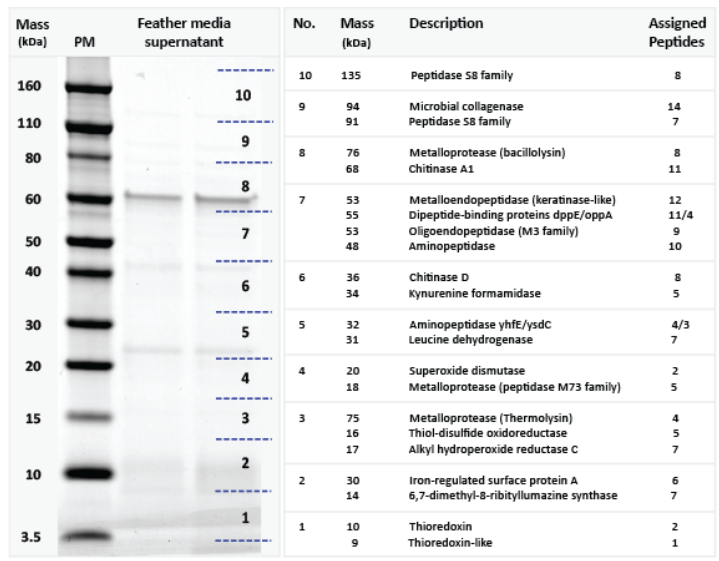
Figure 4. Analysis of extracellular proteins isolated from the supernatant of Bac18 growing on feathers as a sole nutrient source. Left panel shows SDS-PAGE protein gel divided into 10 zones with different molecular weight ranges (PM = protein size markers). Right panel shows the properties of the identified proteins, including predicted masses, descriptions, and the number of assigned peptides. The matching predicted proteins in the bacterial genome are listed in electronic Supplementary Materials, File